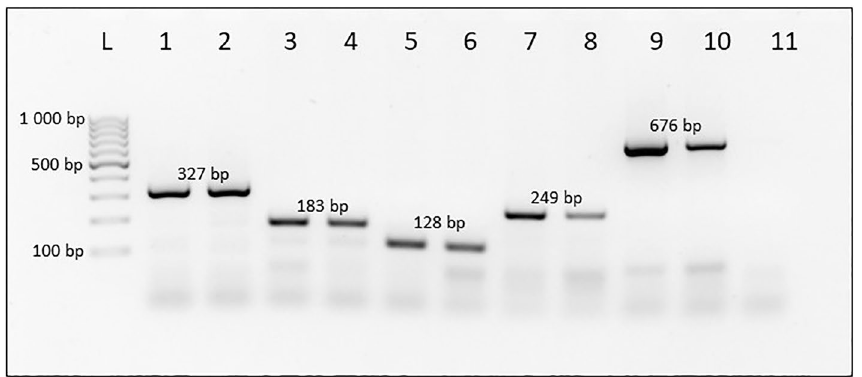
Figure 1. 2% agarose-TAE gel displaying the specificity of the multiplex PCR assay on freshly extracted DNA from colony-reared insects with species-specific amplicon size indicated. Lanes 1 & 2: C. capitata , Lanes 3 & 4: C. cosyra , Lanes 5 & 6: C. quilicii , Lanes 7 & 8: C. rosa , Lanes 9 & 10: B. dorsalis , Lane 11: No template control, Lane L: GeneRuler 100 bp DNA ladder (Thermo Scientific). The original gel is presented in Supplementary Fig. S1a.